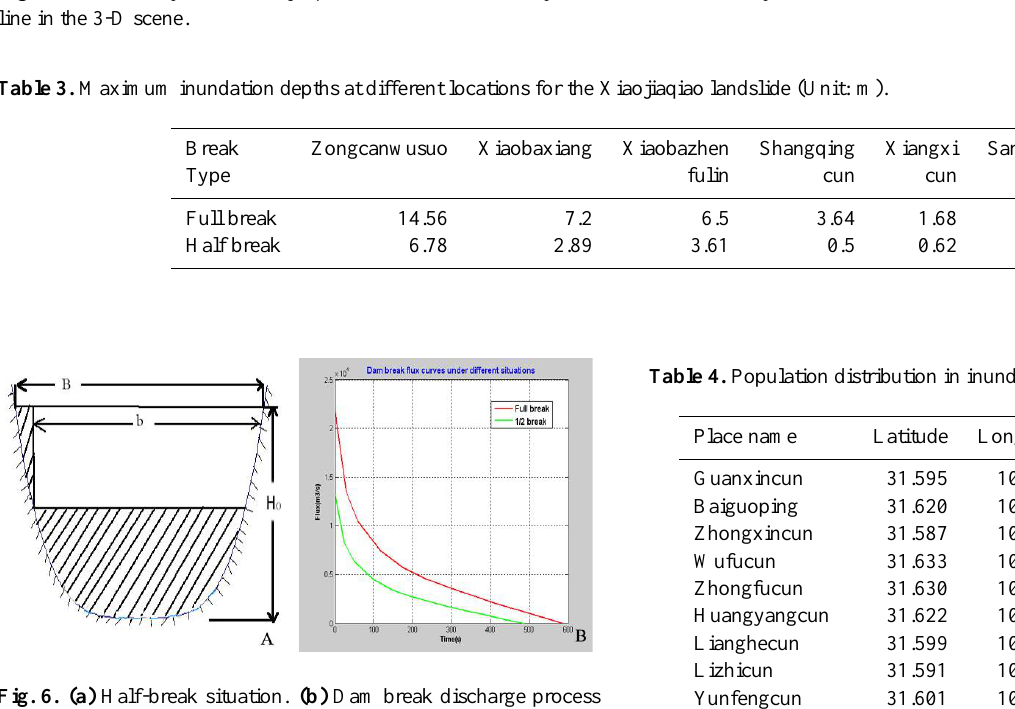
Fig. 6. (a) Half-break situation. (b) Dam break discharge process line calculation result.